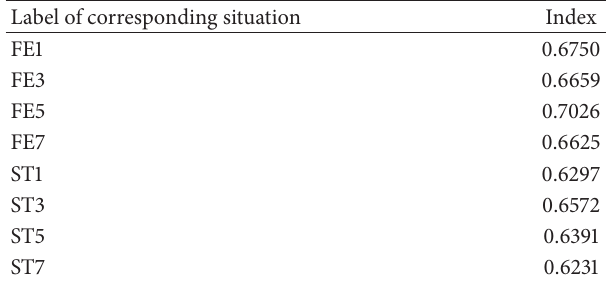
Table 5: 𝑃 , 𝑃 , and 𝑃 for each of the remaining seven situations. Table 6: The Index for each of eight AJ FA FD